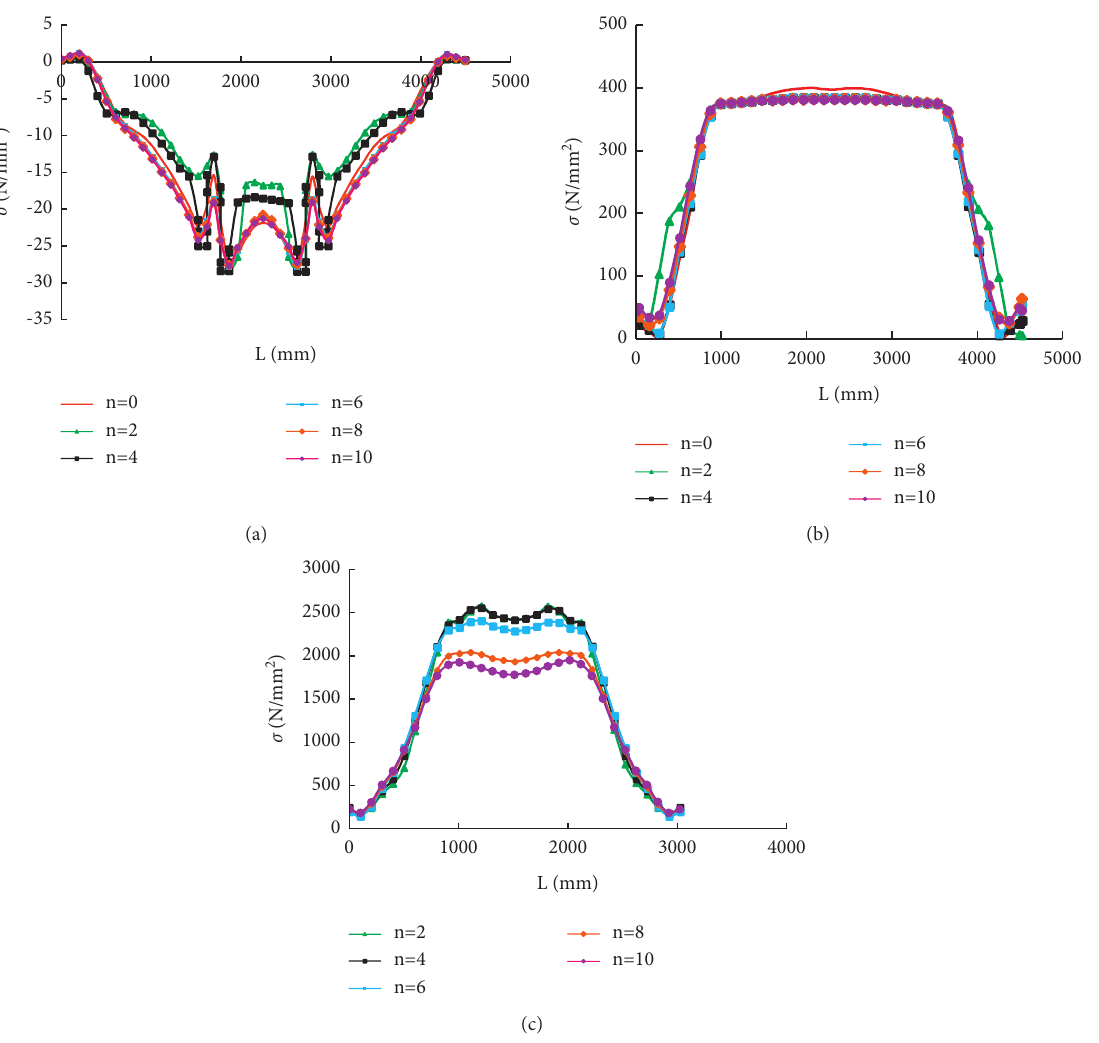
Figure 10: Section stress distribution along the beam length under different amounts of CFRP strips: (a) section of concrete, (b) section of steel reinforcements, and (c) section of CFRP